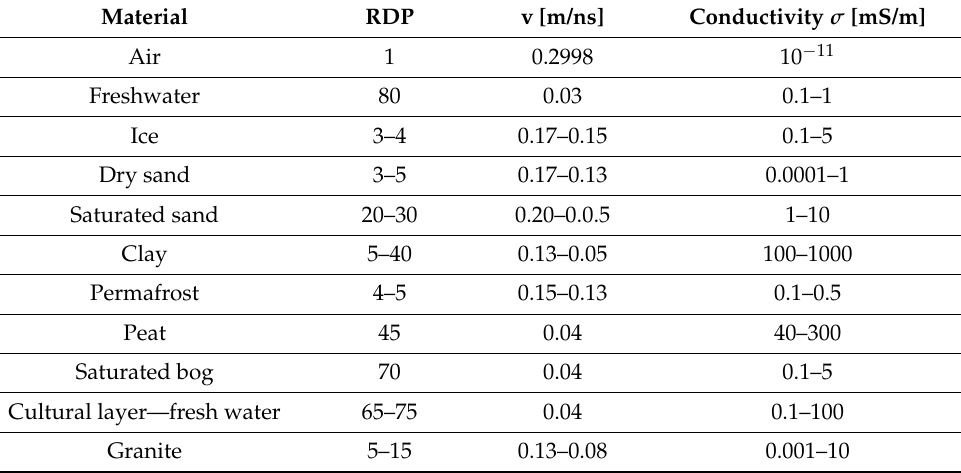
Table 2. Material properties in different relevant media after Conyers [29] and Leckebusch [http: //gpr-parameters.ch (accessed on 28 May 2021)]. The relatively high dielectric pemittivity of peat and cultural layers in fresh water explains the difficulty in detecting organic structures in water-logged environments, despite the electrical conductivity still offering contrasts. The underlying bedrock or stone structures within the peat, mostly granite, again show sufficient deviation to warrant strong reflections.